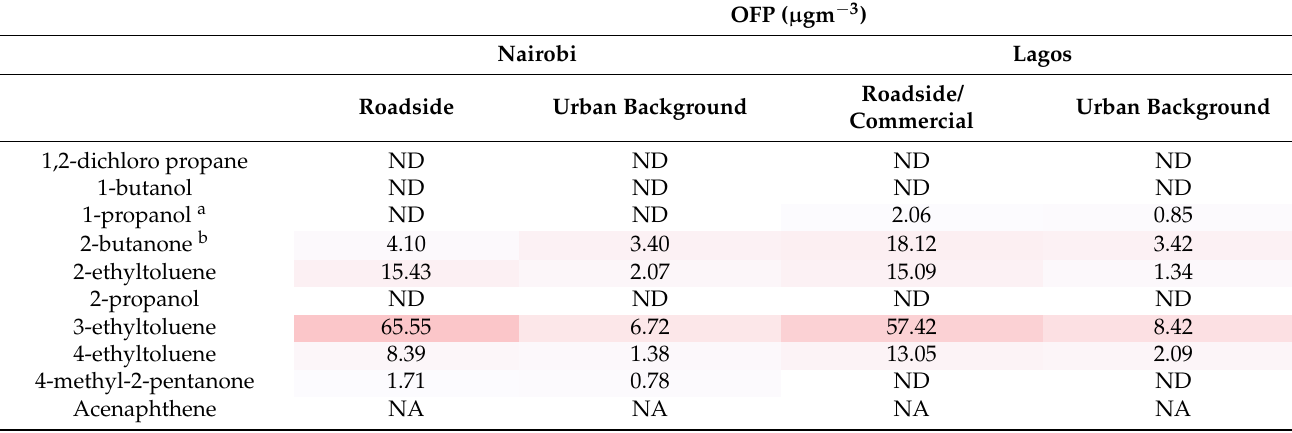
Table 3. Calculated ozone forming potential for targeted VOCs across roadside and urban background sites in Nairobi and Lagos coloured by maximal value per sample group. Maximum incremental reactivity (MIR) determined from Carter (2010) [93] unless stated otherwise. NA indicates that an MIR value for the compound could not be found, and ND indicates that the target compound was not detected in the